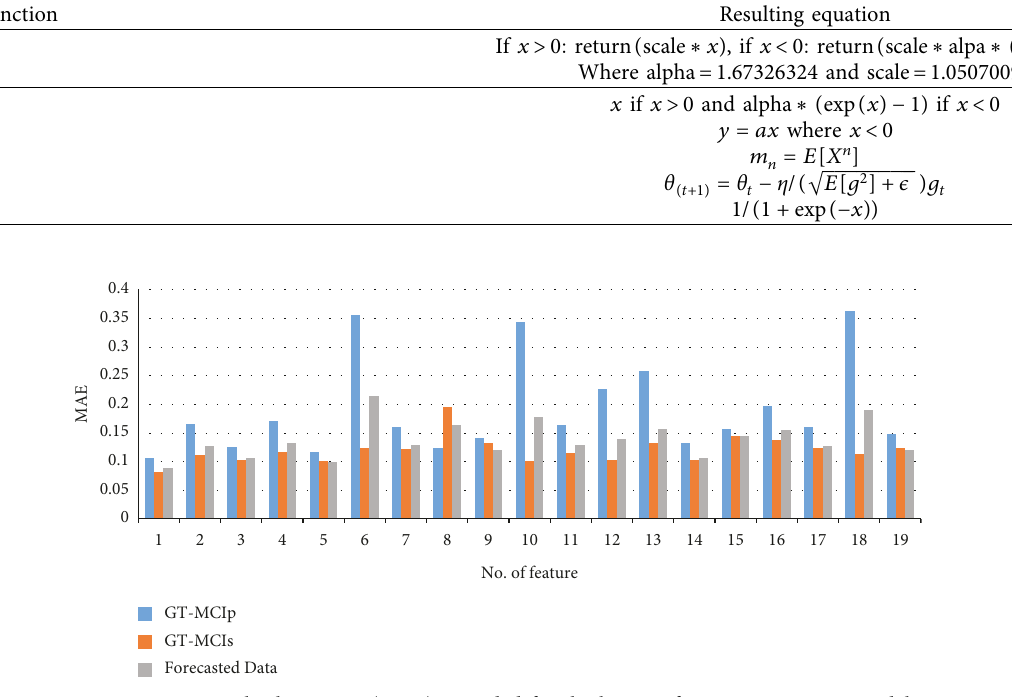
Table 4: Best chosen activation functions and optimisers.